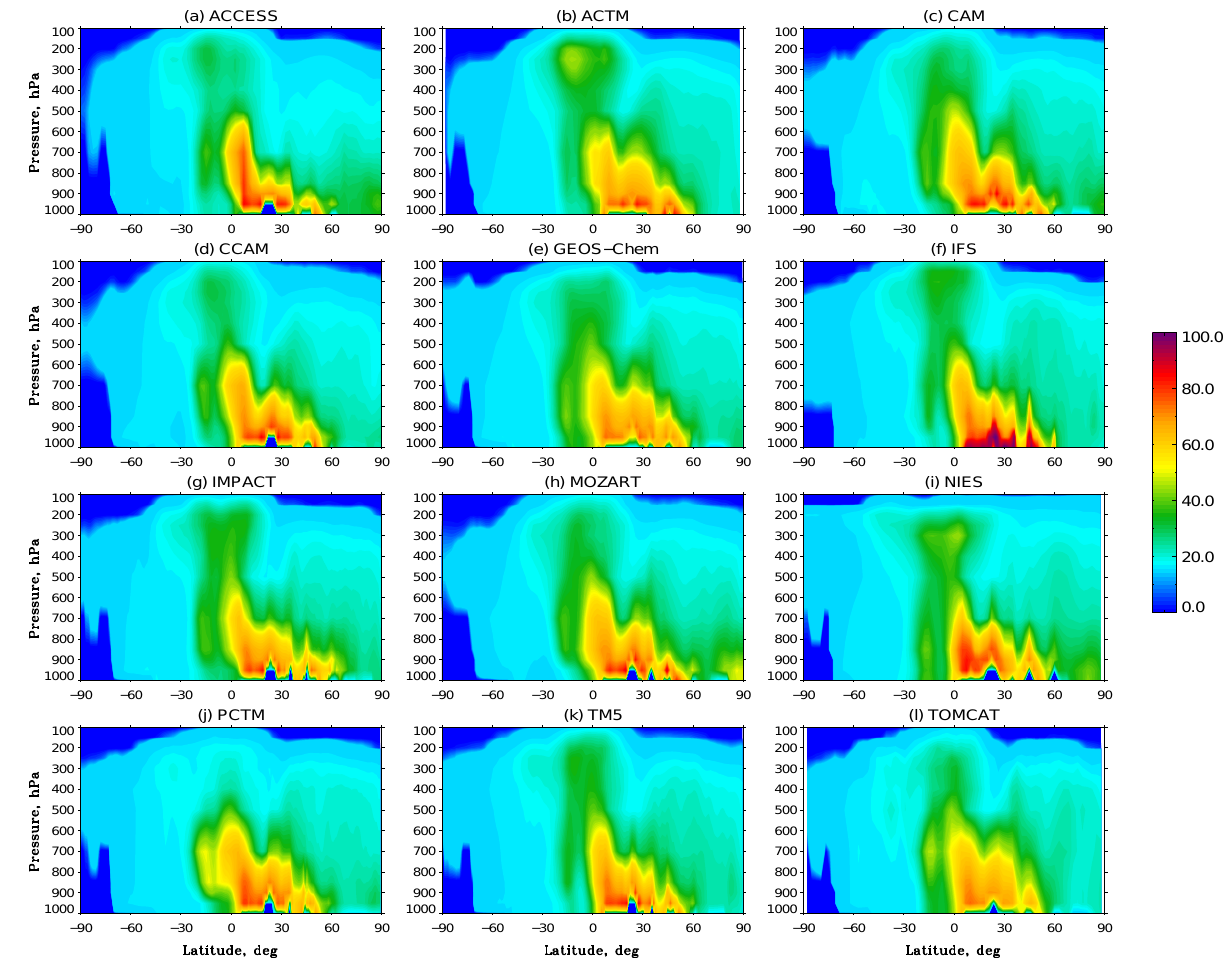
Fig. 6. Seasonal mean (DJF) latitude–pressure distributions of 222 Rn concentrations (10 − 21 molmol − 1 ) along 5 ◦ E longitude as simulated by the TransCom-CH4 models for the year 2003: (a) ACCESS, (b) ACTM, (c) CAM, (d) CCAM, (e) GEOS-Chem, (f) IFS, (g) IMPACT, (h) MOZART, (i) NIES08i, (j) PCTM, (k) TM5 and (l)